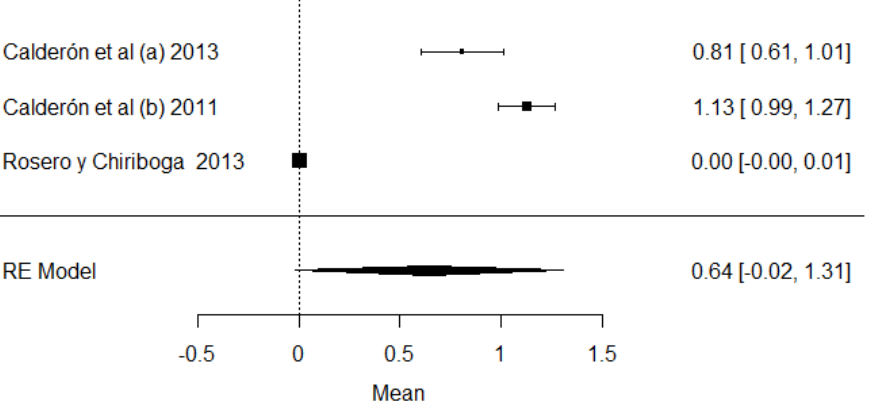
Figure 20. Forest plot of ptaquilosides [15,22,70].